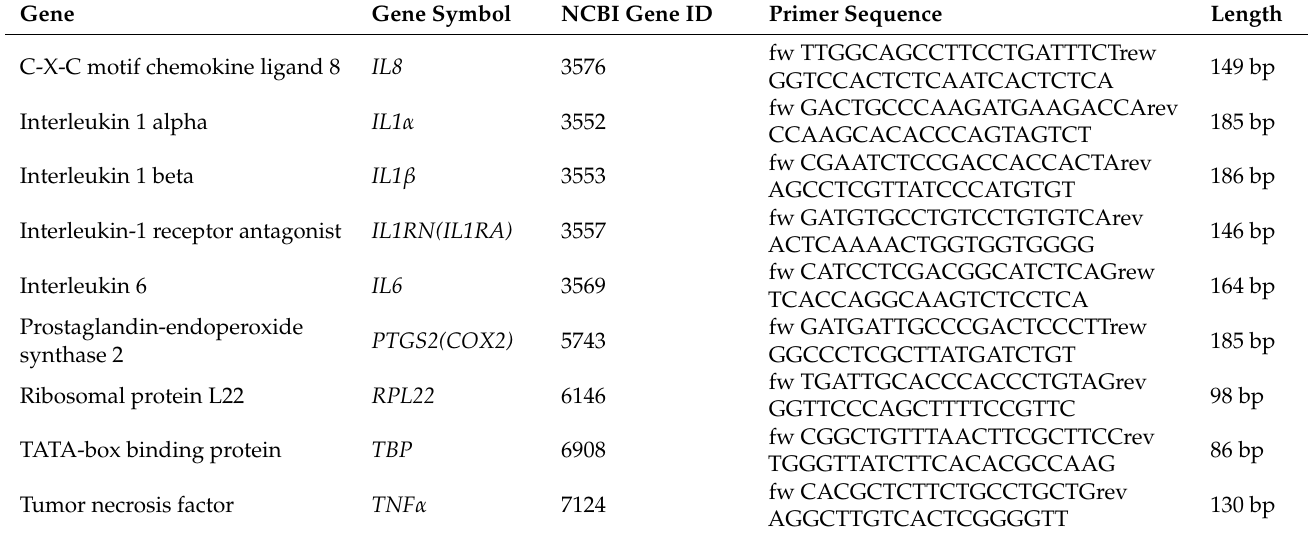
Table 1. qPCR primer sequences of human genes indicated in 5’-3’ direction. bp, base pairs. Length, amplicon length. Gene Gene Symbol NCBI Gene ID Primer Sequence